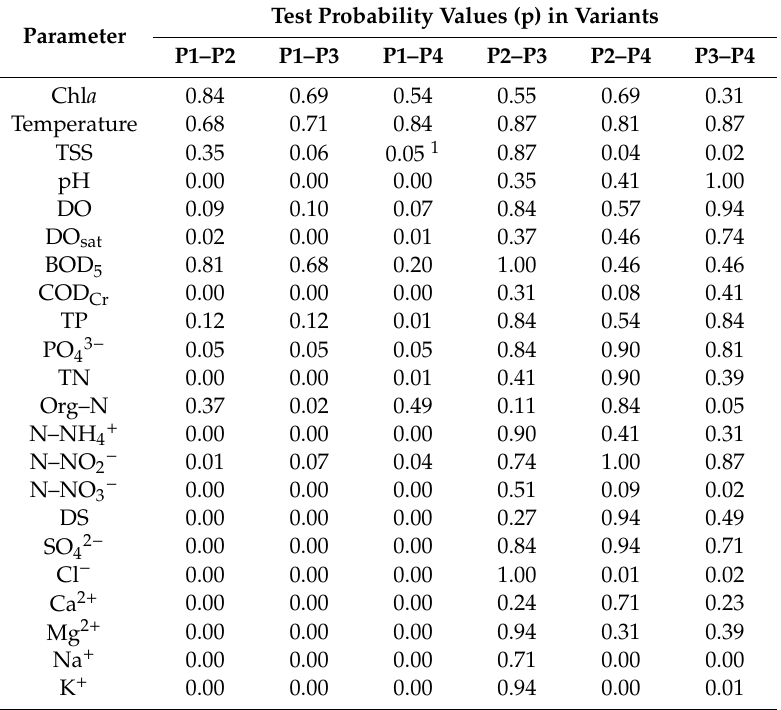
Table 3. Comparison of water quality parameters values between measurement-control points using non-parametrical Mann-Whitney U